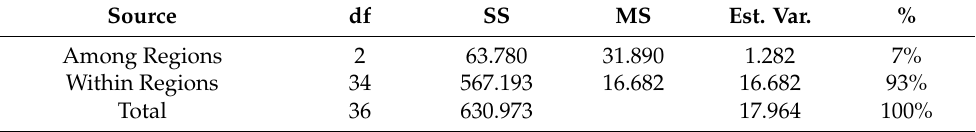
Table 5. Analysis of molecular variance (AMOVA) based on SSR marker in maize landrace populations. Source df SS MS Est. Var. % Among Regions 2 63.780 31.890 1.282 7% Within Regions 34 567.193 16.682 16.682 93% Total 36 630.973 17.964